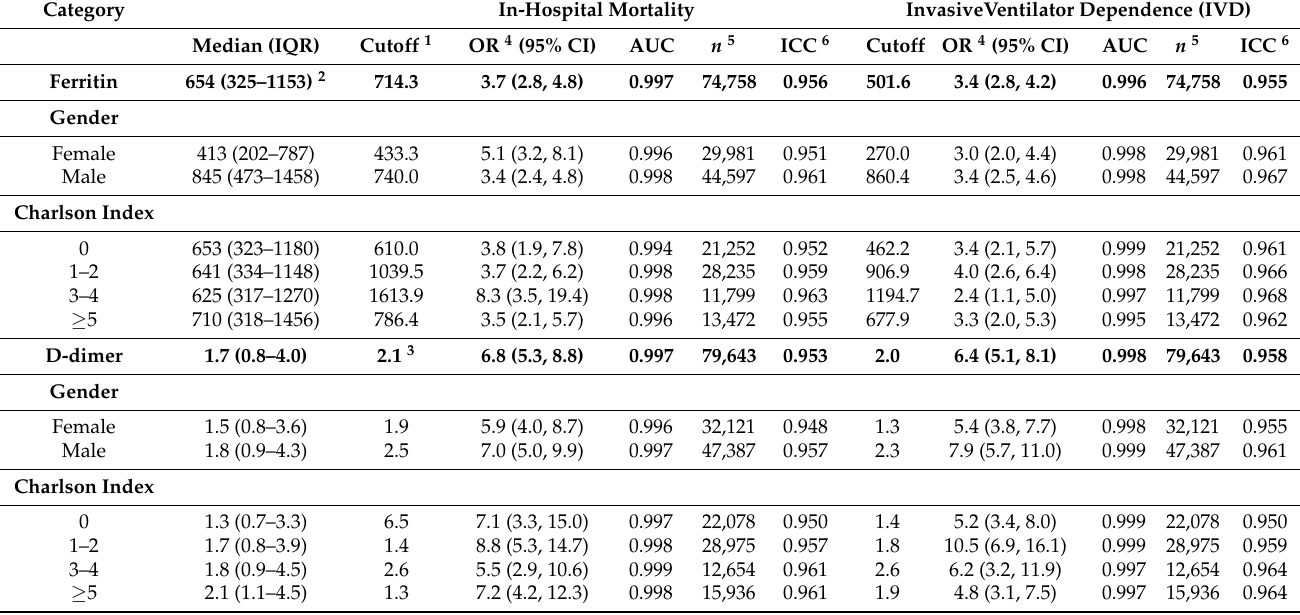
Table 3. Biomarker optimal cut-offs for complications in COVID-19 patients, overall and stratified by gender and Charlson weighted comorbidity index